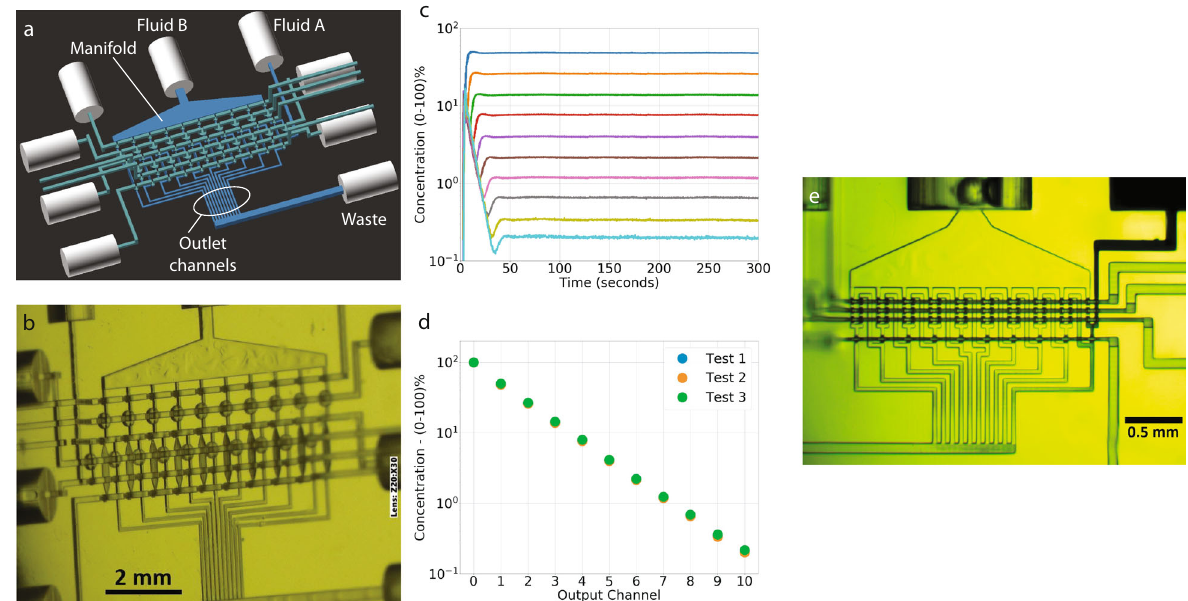
Fig. 6 10-stage twofold serial diluters. a CAD drawing and ( b ) microscope image of membrane valve-based serial diluter. c Normalized fl uorescein concentration as a function of time for all ten output channels (outputs 1 – 10) and the input concentration (output 0). d Steady state normalized fl uorescein concentration at each output channel for three repeated tests. e Microscope image of 10-stage twofold serial diluter made with squeeze valve-based 1:1 mixer